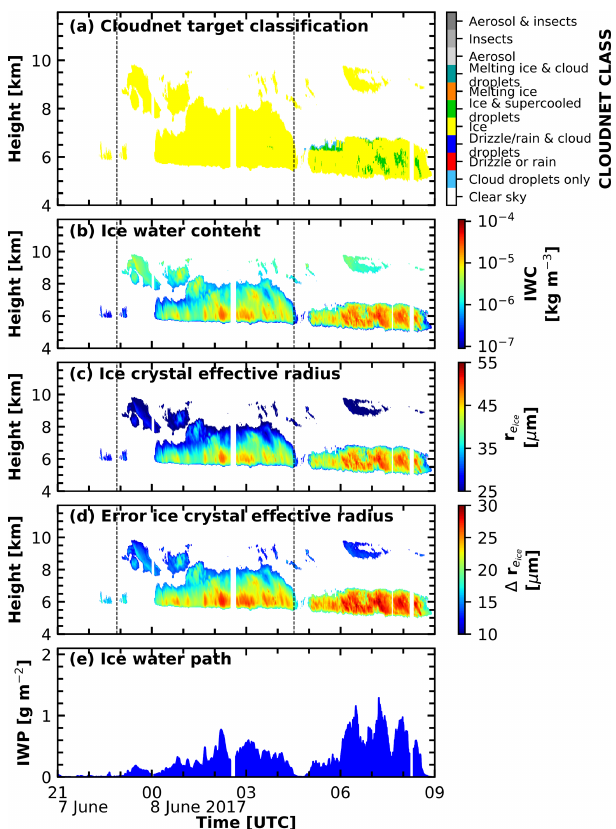
Figure 16. Cloudnet products for 7 June 2017 21:00UTC to 8 June 2017 09:00UTC: (a) target classification, (b) ice water content, (c) ice crystal effective radius, (d) uncertainty in the retrieved ice crystal effective radius as derived from error propagation, and (e) ice water path. The dashed lines mark the times of the radiosonde launches shown in Fig. 15 (note: the time of the first and last launch shown in Fig. 15 was before and after the presented time